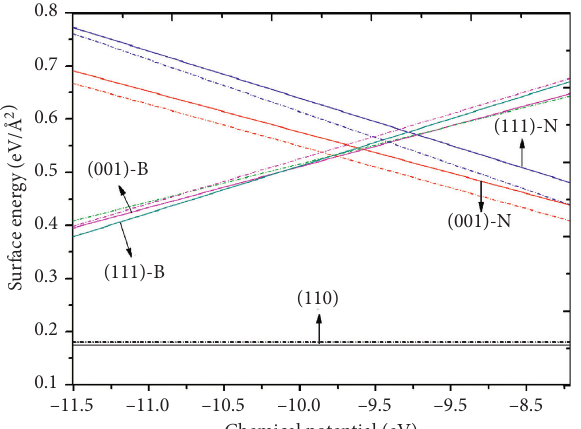
Figure 4: Surface energies of the three low-index cBN single-crystal surfaces as a function of the N chemical potential. The dashed line represents the theoretically calculated results obtained in